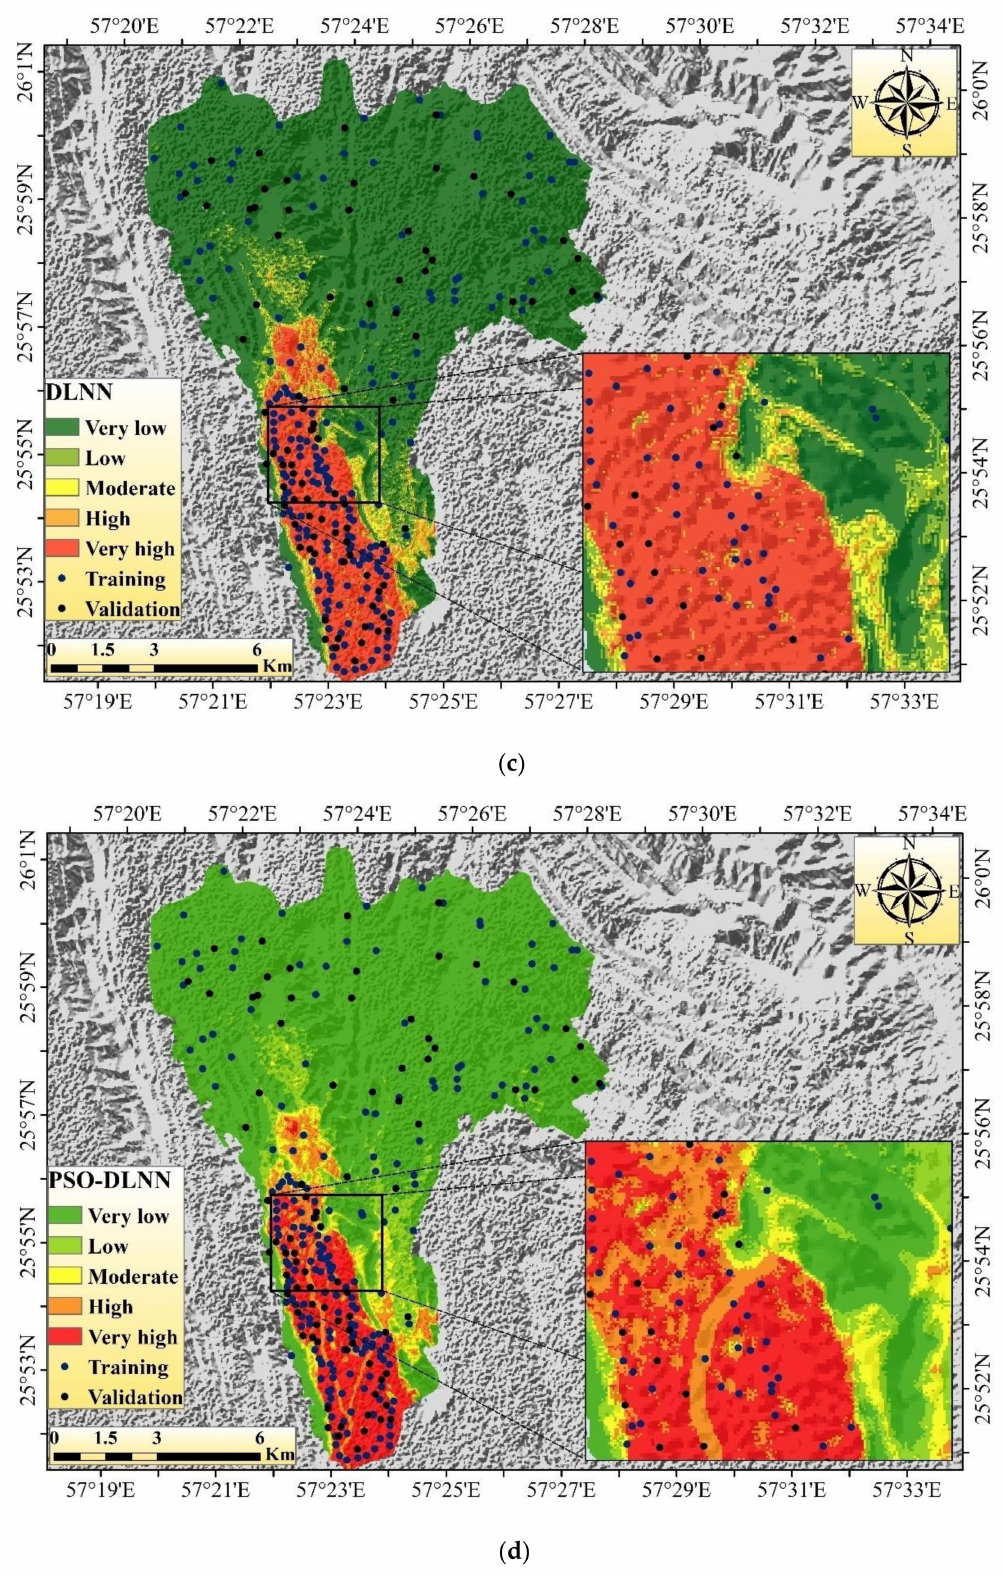
Figure 8. Head-cut gully erosion map using the four models: ( a ) SVM; ( b ) ANN; ( c ) DLNN; ( d )